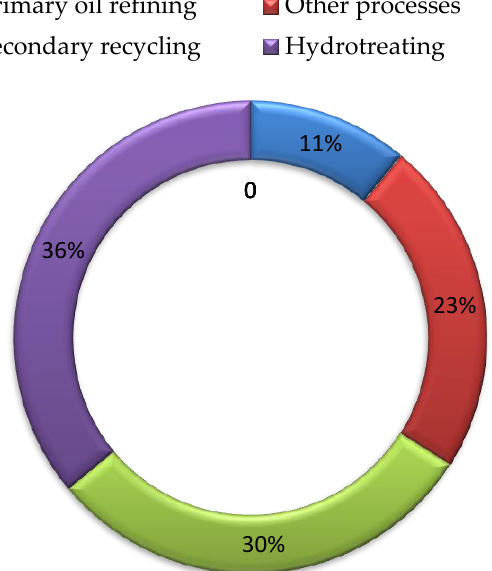
Figure 6. Percentage of CO 2 emissions from different sources in oil refining.